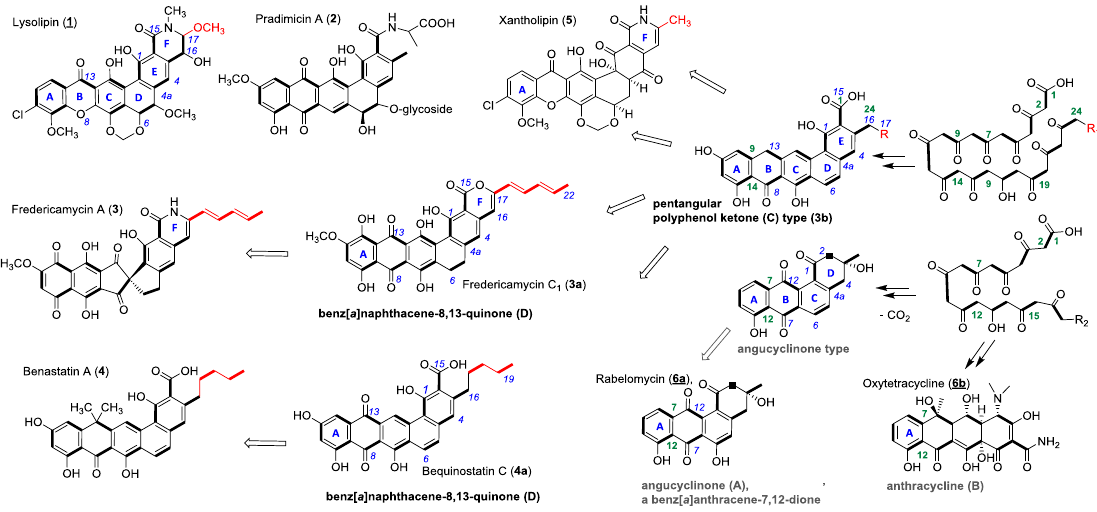
Figure 1. Chemical structures of PKS II products ( 1 – 6 ) and examples of biosynthetic congeners ( 3a , b , 4a ). PKS chains (acetate units bold) of angucyclinone ( A ) and anthracycline ( B ) type structures start to cyclize with ring A at C-7/C-12. Benz[a]naphthacene ( C ) and benz[a]naphthacene quinone ( D ) type structures cyclize starting with C-9/C-14 according to polyketide chain numbering (green). Variations of δ-substituents of ring-F highlighted in red. R = H or alkyl-, allylic carbon chains (usual chemical nomenclature in blue).